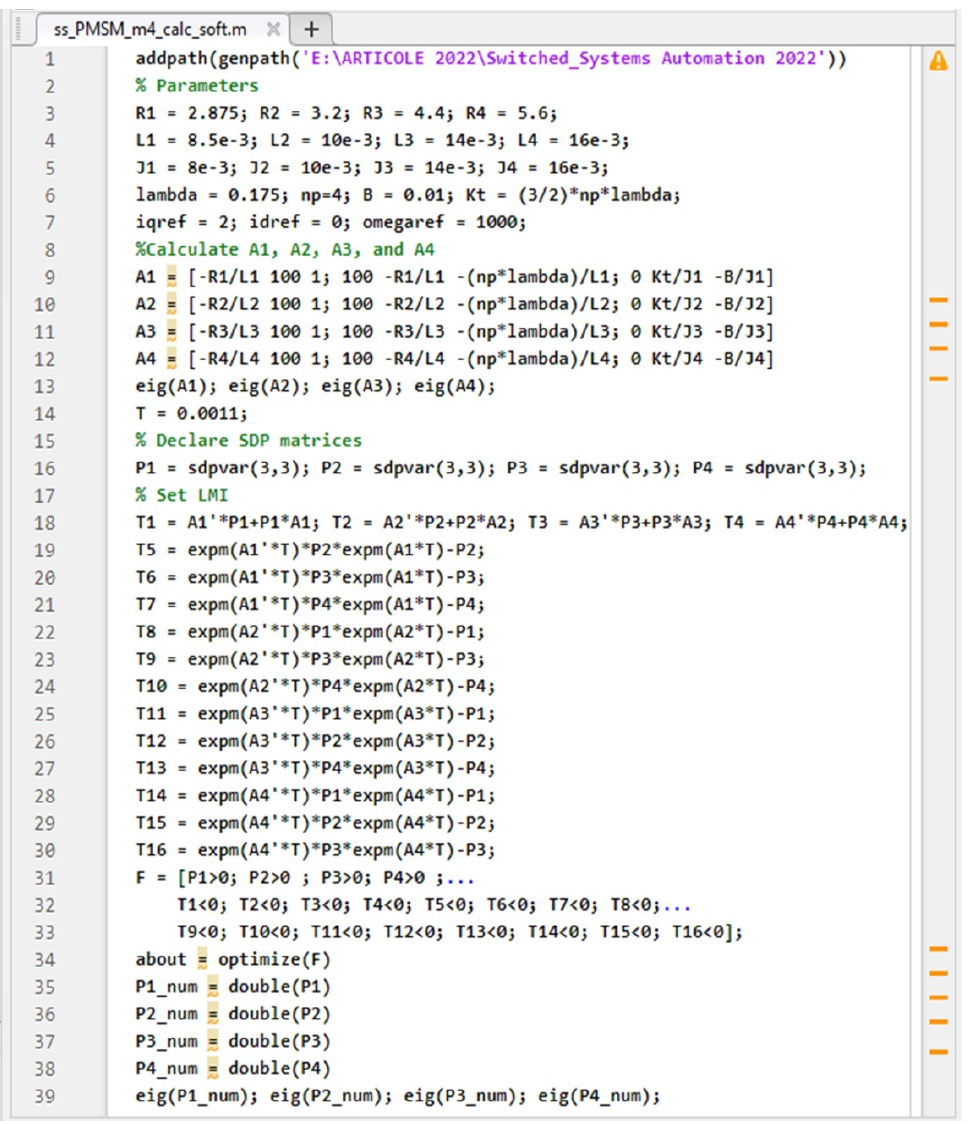
Figure 23. Matlab program for matrices A i and P i determination—case 2.